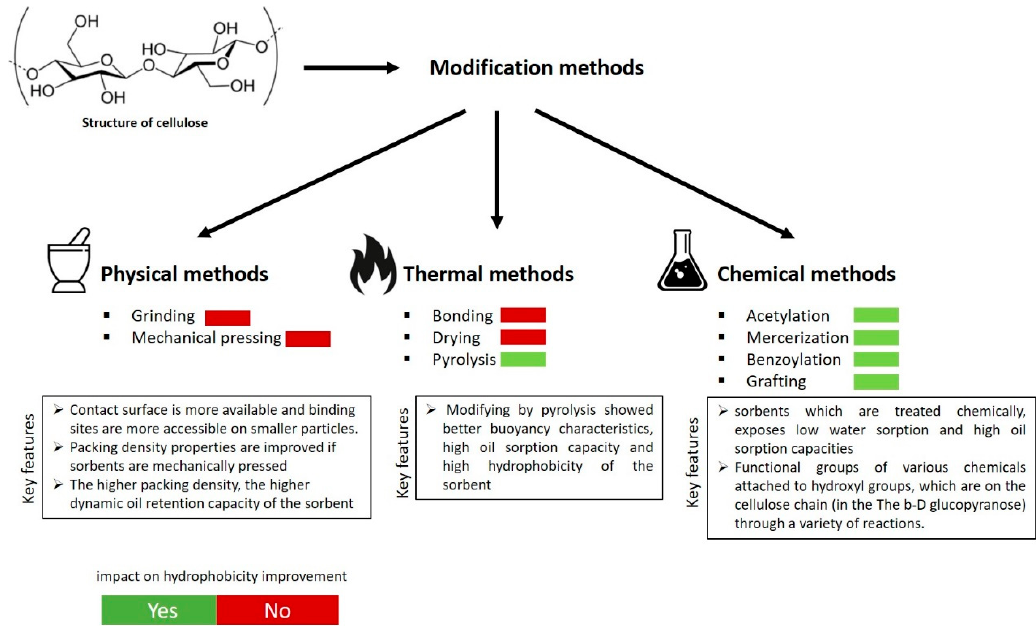
Figure 4. Classification of modification methods for hydrophobicity improvement in natural-based sorbents (authors’ own study).